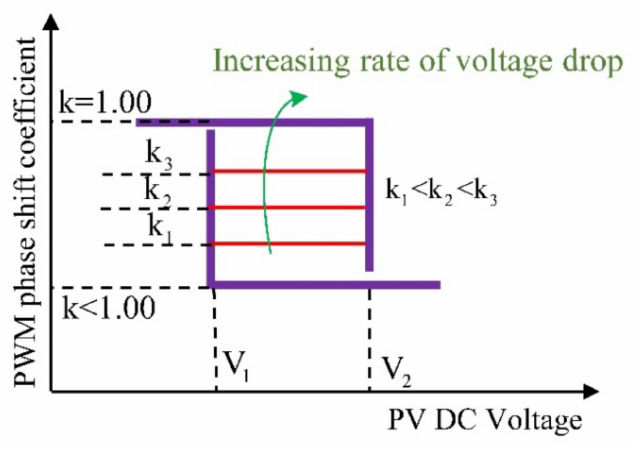
Figure 4. Proportional